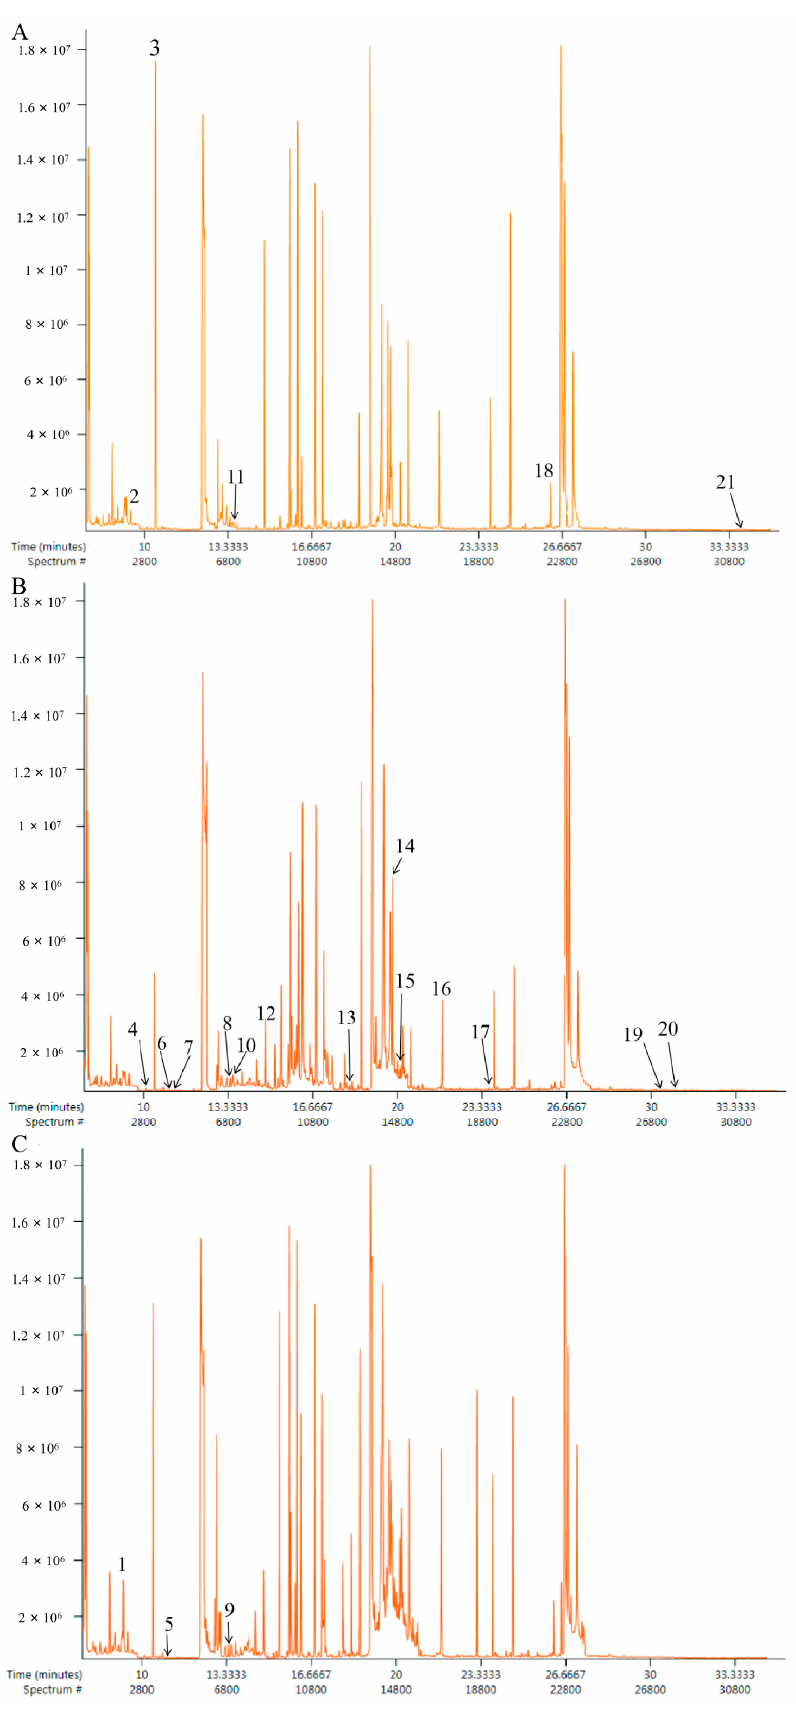
Figure 3. GC/MS chromatograph of urine samples obtained from the NC group ( A ), RA group ( B ) and AA group ( C ), respectively.